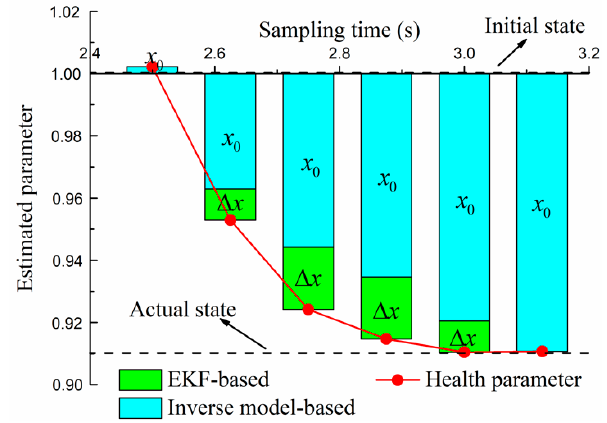
Figure 15. The local analysis of SW2 in Case 2.